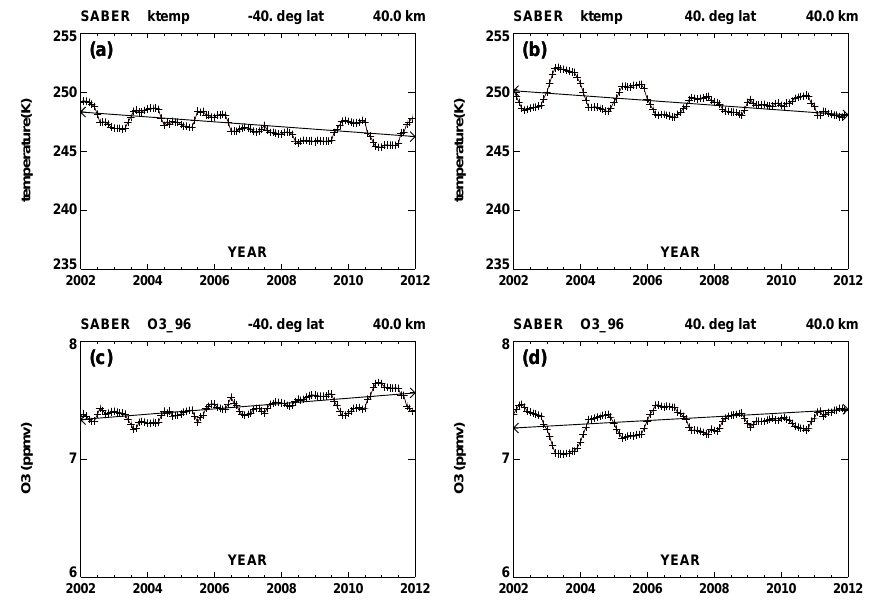
Figure 1. Top row: temperature trends (straight lines) from 2002 to 2012 at 40km; 40 ◦ S (left) and 40 ◦ N (right) latitude. Pluses denote data with seasonal and local time variations removed. Bottom row: corresponds to top row, but for ozone mixing